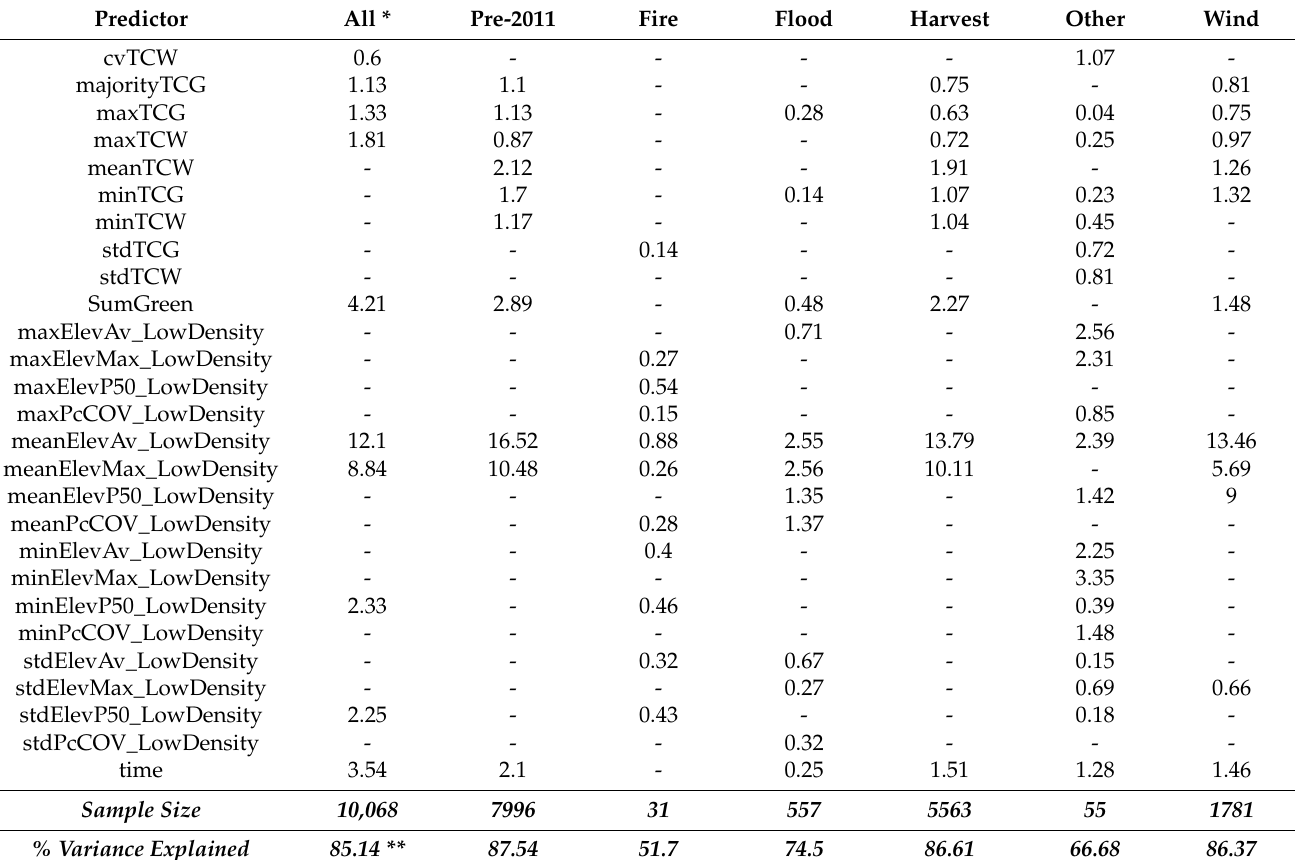
Table 3. Percent increase in mean squared error when predictor is removed (RF) for agent specific and combined above ground biomass models.